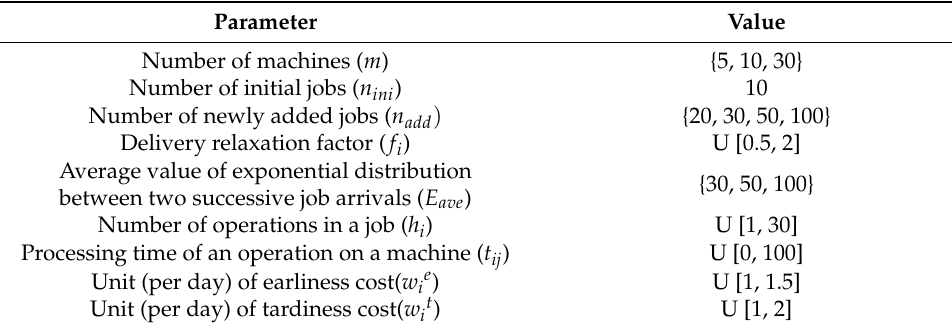
Table 2. Parameter settings of different production